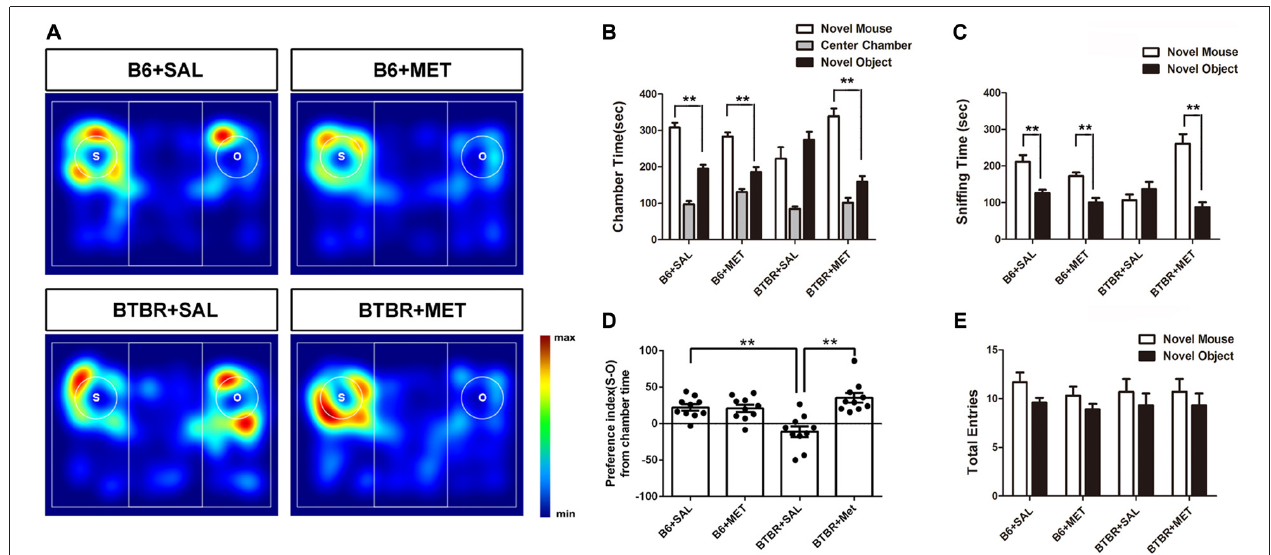
FIGURE 3 | Early metformin treatment reversed social approach deficits in the BTBR mouse model of autism. (A) The heat maps show the total time and location in BTBR and B6 mice during the sociability chamber test. “O” and “S” represent object and mouse, respectively. Warmer colors (red) represent longer stay. (B) BTBR mice show that spending similar time staying with a novel object compared to a novel mouse. Early metformin treatment can reverse the social deficit by increasing the time interaction with the novel mouse. (C) BTBR mice spend about equal sniffing time with a novel object compared to control mice. Early metformin treated mice increased the time sniffing with the mouse. (D) Compared to control mice, BTBR mice showed a lower preference index (S-O/total), and early metformin treatment can improve sociability for increasing the preference index. (E) There was no significant difference in total entries observed in all groups. Data are presented as the means ± SEM. n = 10. ∗∗ P <